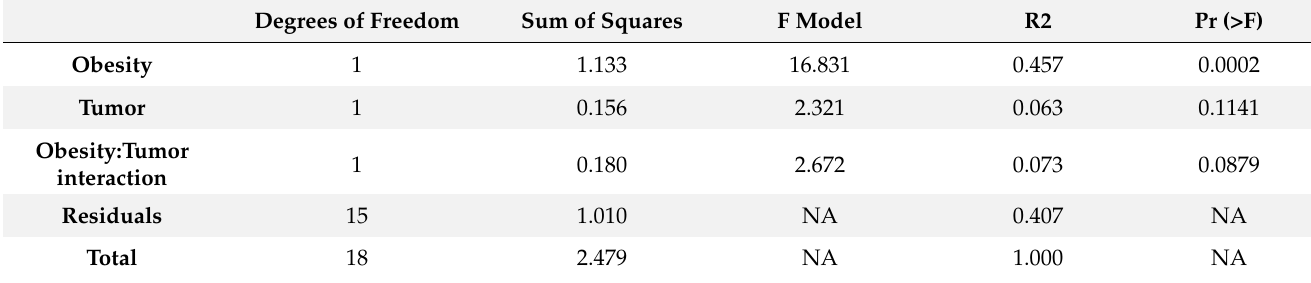
Table 1. PERMANOVA (analysis of variance) of taxonomic groups: the significance of differences between treatments. Degrees of Freedom Sum of Squares